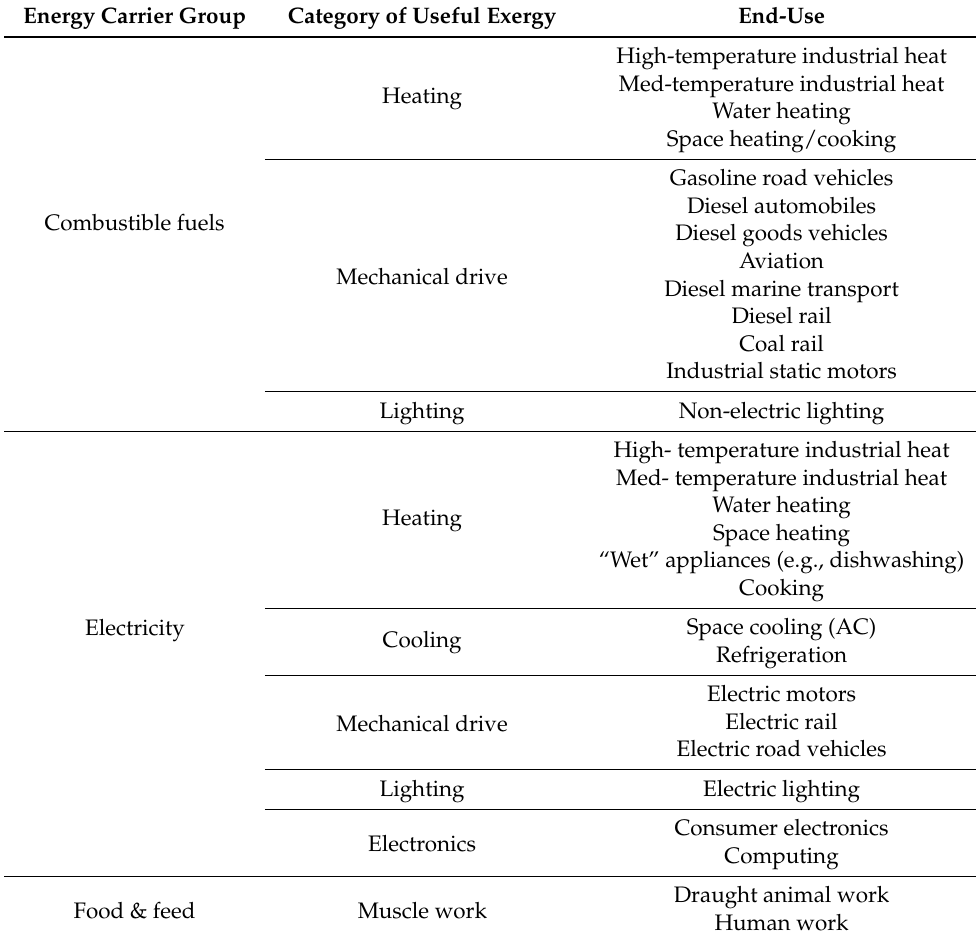
Table 1. Breakdown of end-uses, by useful exergy category and energy carrier